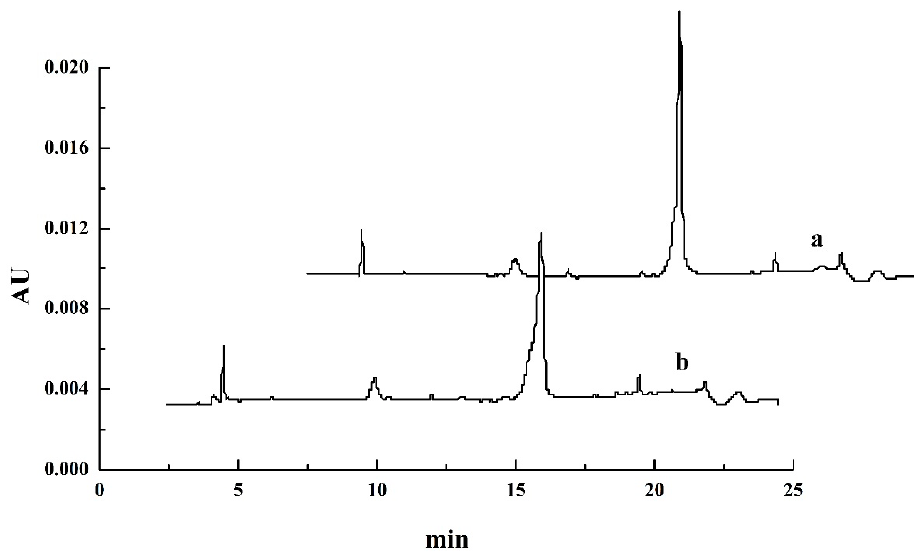
Figure 4. RP-HPLC chromatograms of the OVA standard ( a ) and the top phase of the ATPS ( b ).